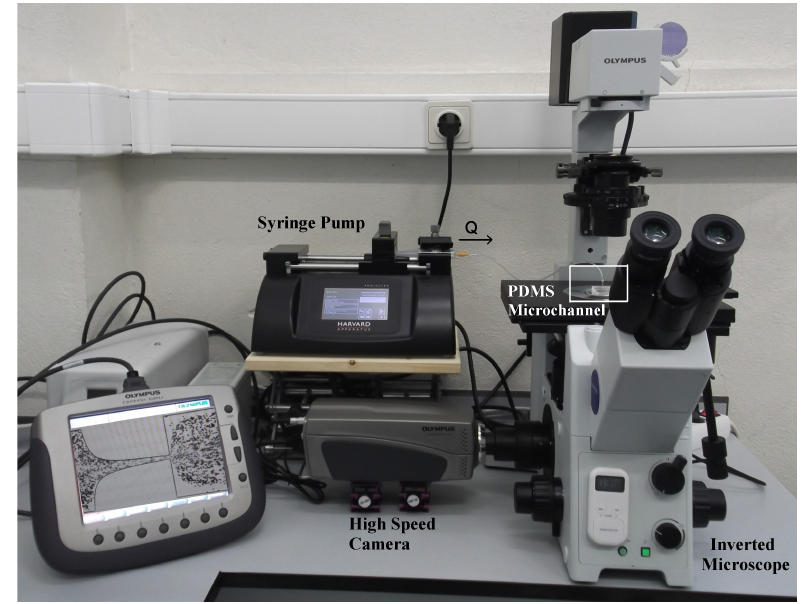
Figure 2. A view of experimental set-up: an inverted microscope (IX71, Olympus) and a 10 × objective lens, combined with a high-speed camera (i-SPEED LT, Olympus). The PDMS microchannel was placed on the stage of the microscope where the flow rate ( Q ) of the working fluids was kept constant (at 5 and 20 µL/min) by means of a syringe pump (Harvard Apparatus PHD